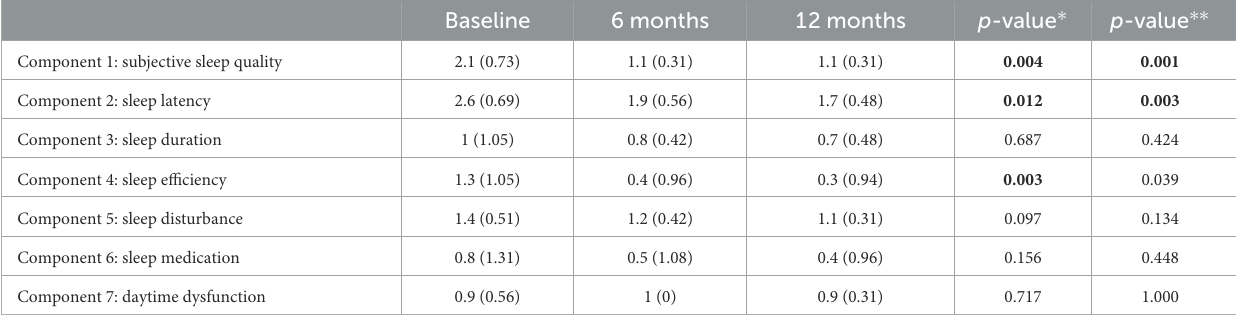
TABLE 2 PSQI test scores and its subdomains in the people with Parkinson’s disease, at the baseline and after 6 and 12 months of LCIG infusion. Baseline 6 months 12 months p -value ∗ p -value